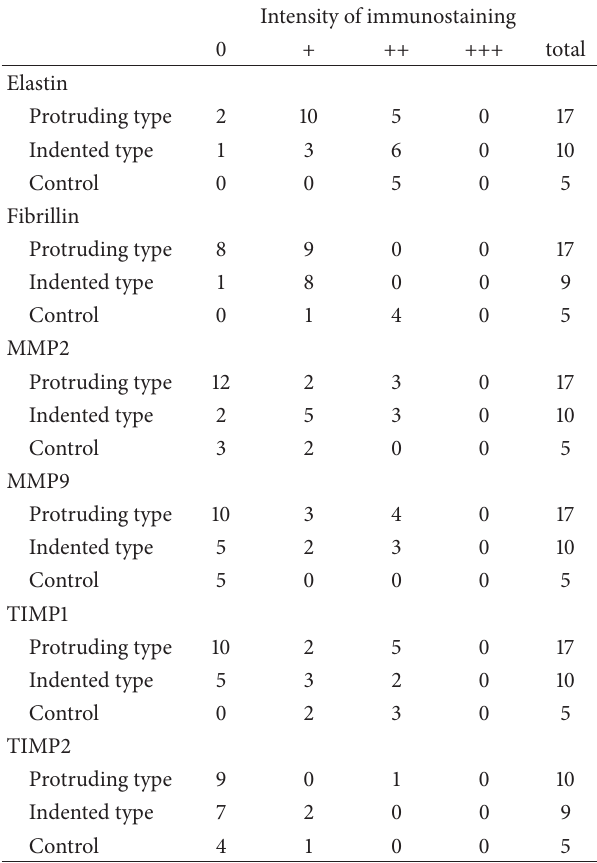
Table3:Immunohistochemistryresultsforelastogenesisanddegra- dation markers in anetoderma lesional dermis according to clinical